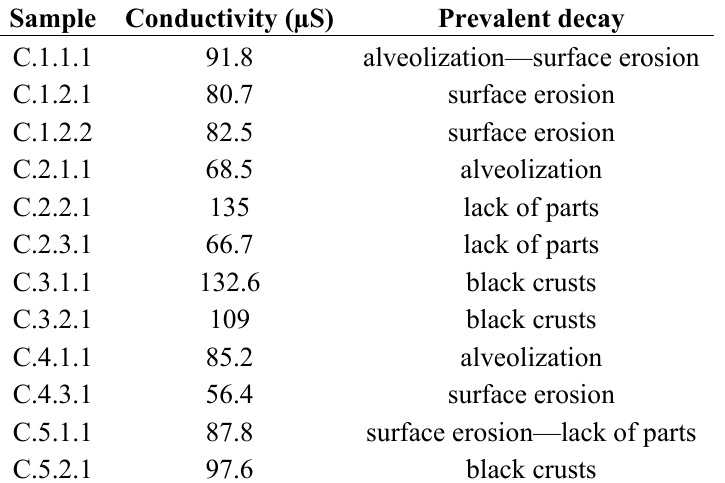
Table 2. Conductivity